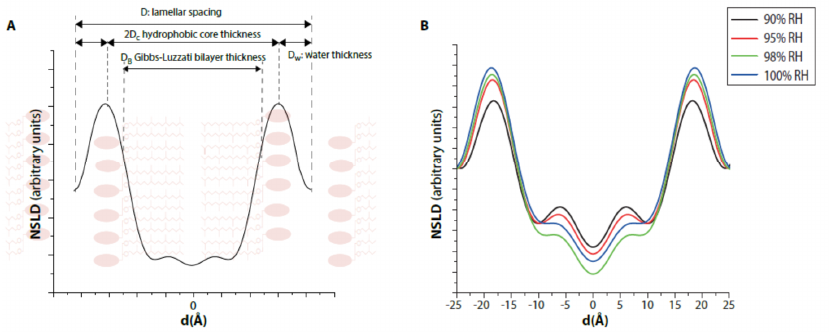
Figure 3. Neutron scattering length density (NSLD) as a function of relative humidity (RH). ( A ) Scheme presenting the thicknesses that can be extracted from the NSLD. ( B ) Lipids hydrated with 8% D 2 O. NSLD of DoPhPC:DoPhPE (9:1) at 25 ◦ C as a function of humidity: 90% RH (black), 95% RH (red), 98% RH (green), 100% RH (blue).